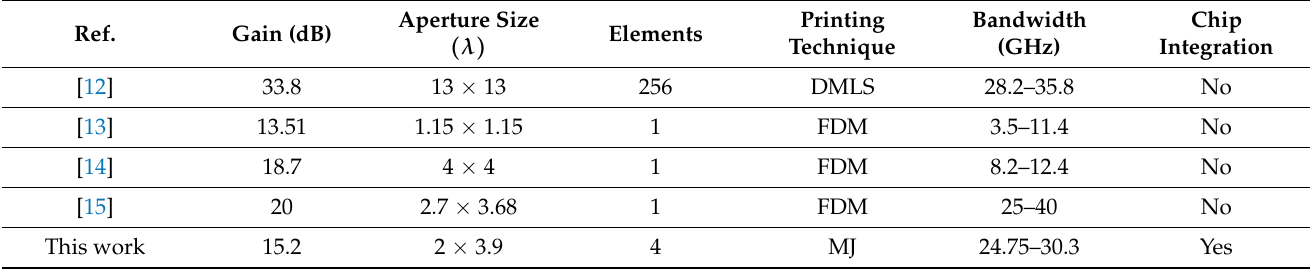
Table 3. Comparison with other studies using 3D printing technology for horn antennas.